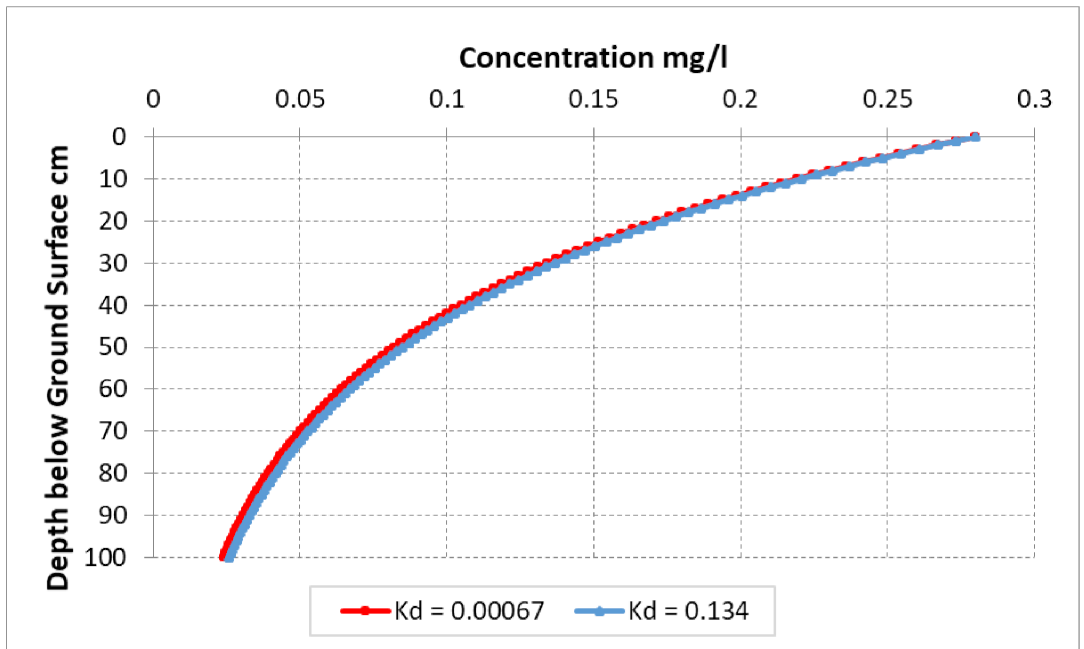
Figure 7. The effect of the distribution coefficient ( K d )—Silt loam